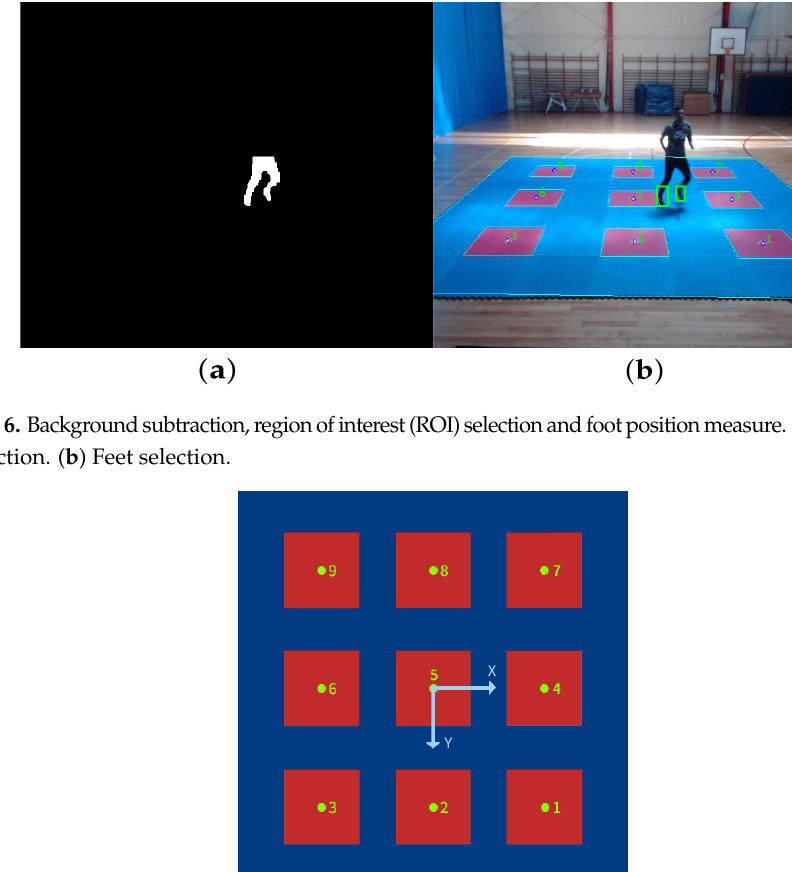
Figure 7. Coordinate system, floor level plane centered on target